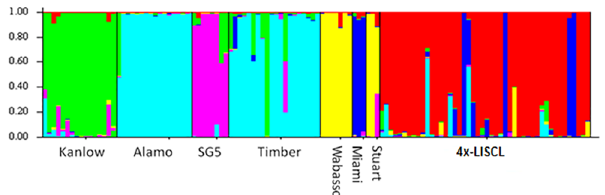
Fig 4. STRUCTURE analysis of SSR markers from L4x LISCL plants (n = 46) and seven L4x cultivars. Individuals are shown as a vertical line representing the membership fractions for each of the K populations and sorted according to q-value (K =